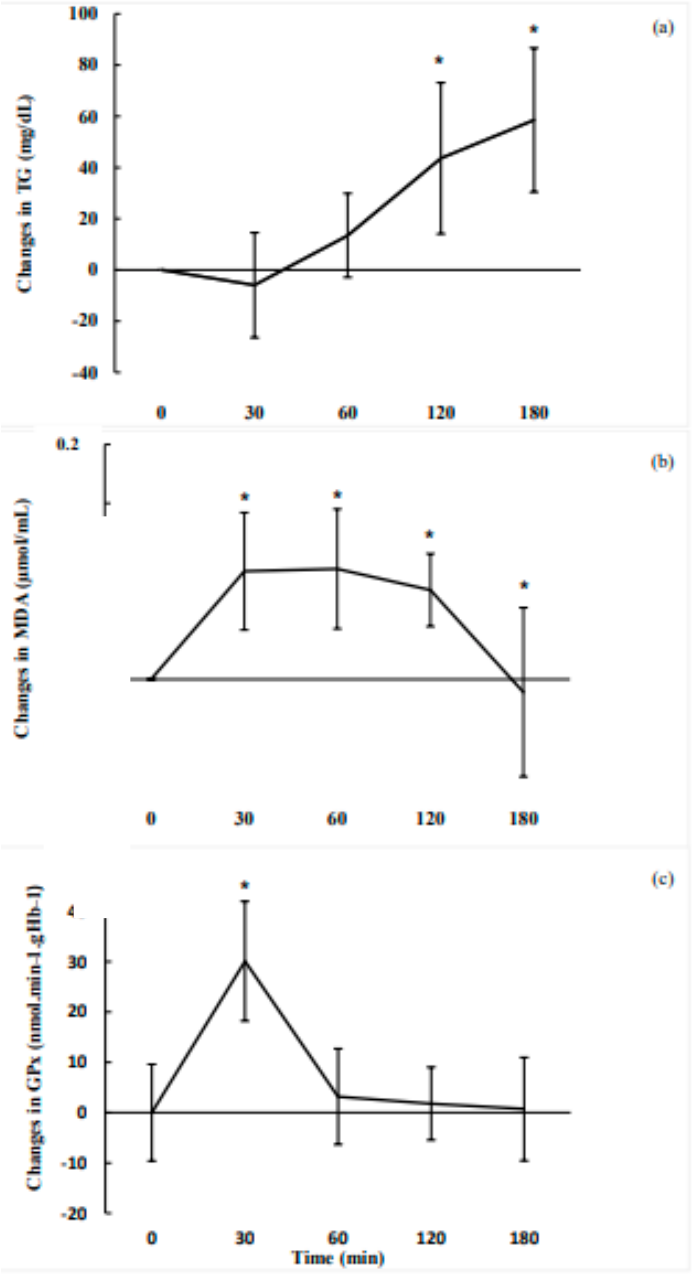
Figure 2. Induction of hypertriglyceridemia ( a ) and oxidative stress assessed by lipid peroxidation ( b ) and GPx activity ( c ) at time points 30, 60, 120 and 180 min in individuals with dyslipidemia, where n = 13. The asterisk (*) indicates significant differences from the Student’s t test for a sample in relation to a reference value (baseline) with Bonferroni correction and p < 0.001. Values are expressed as the mean and standard error of the mean, represented by the error bars. TG = triglycerides; MDA = malondialdehyde; GPx = glutathione peroxidase.